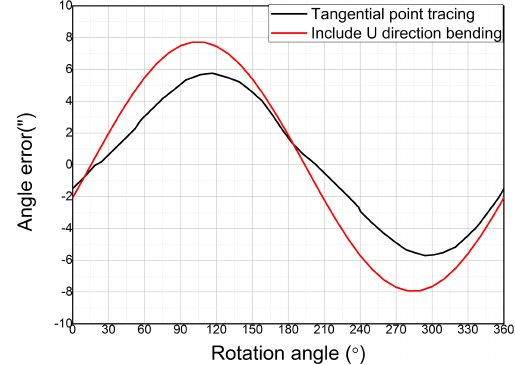
Figure 7. Fourth pin angle error including bending effect.